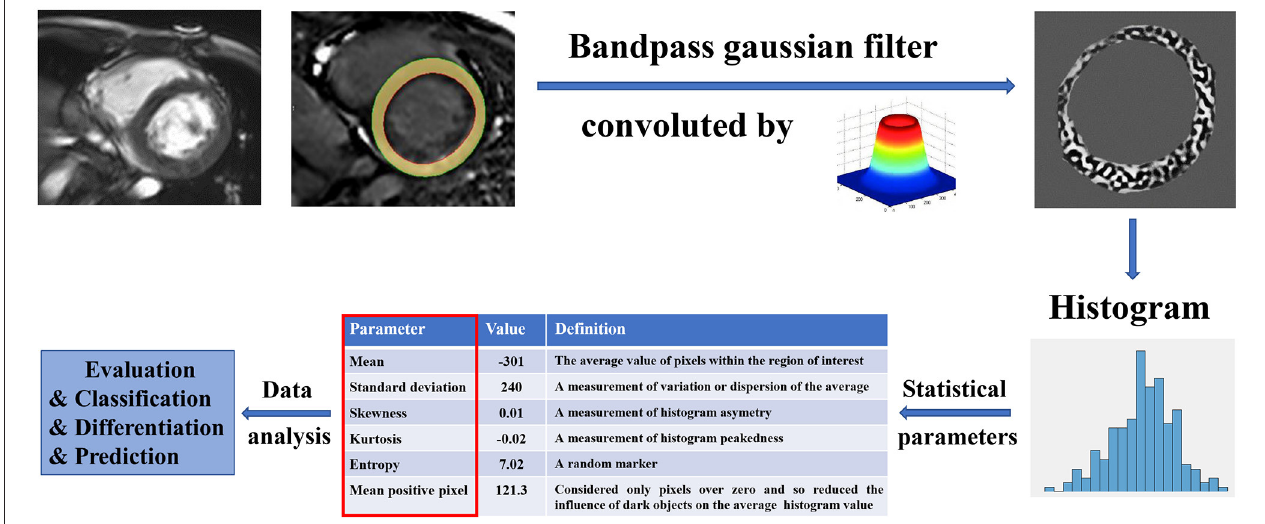
FIGURE 4 | A schematic diagram illustrating the whole texture analysis (TA) applied on CMR. The myocardium in a CMR image was convolved by a bandpass Gaussian filter to enhance the image and highlight the variance. The histogram of the enhanced myocardium was computed to obtain a couple of statistic parameters, such as mean, SD, skewness, kurtosis, entropy, and mean positive pixel. These parameters were furthermore analyzed among different patients for evaluation, classification, differentiation, and prediction. CMR, Cardiac magnetic